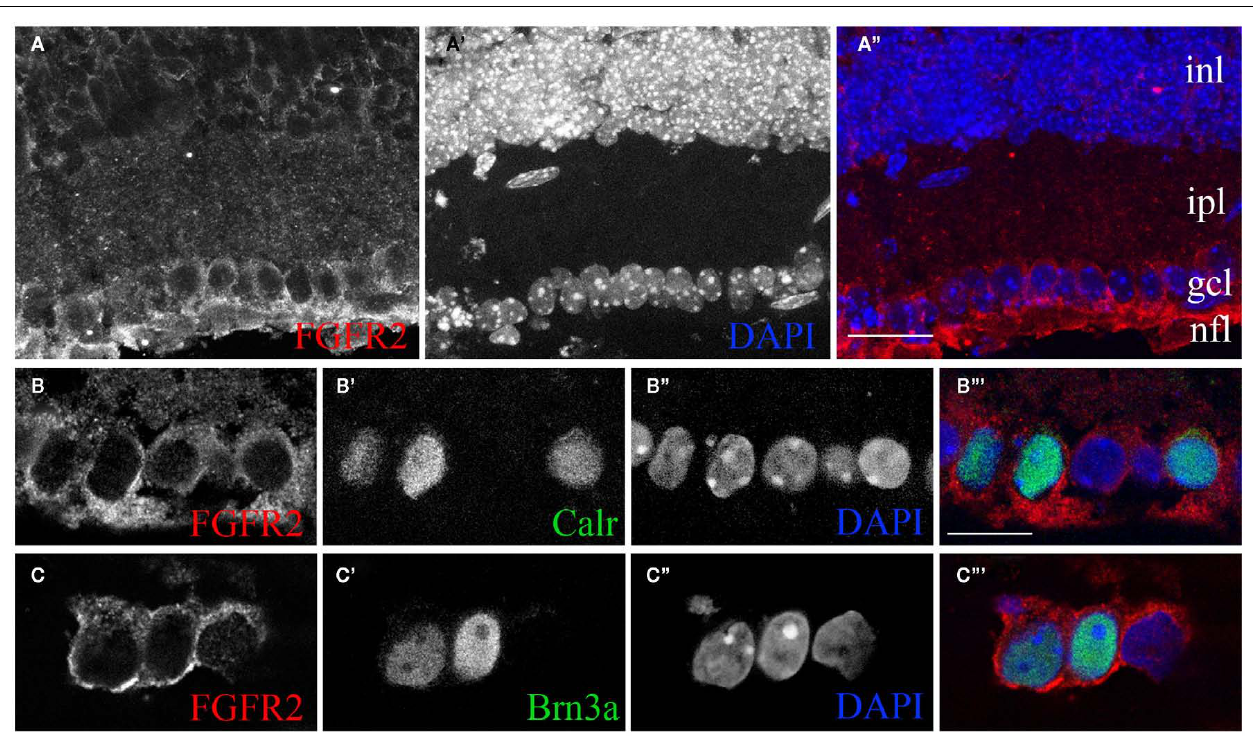
(B,C) Single optical slices from confocal analyses of retinal cross-sections immunostained for FGFR2 and either Calr (B) or Brn3a (C) . Nuclei were labeled with DAPI. inl, inner nuclear layer; ipl, inner plexiform layer; gcl, ganglion cell layer; nfl, nerve fiber layer. Scale bar in (A) = 50 μ m and in (B) = 20 μ m for (B,C)